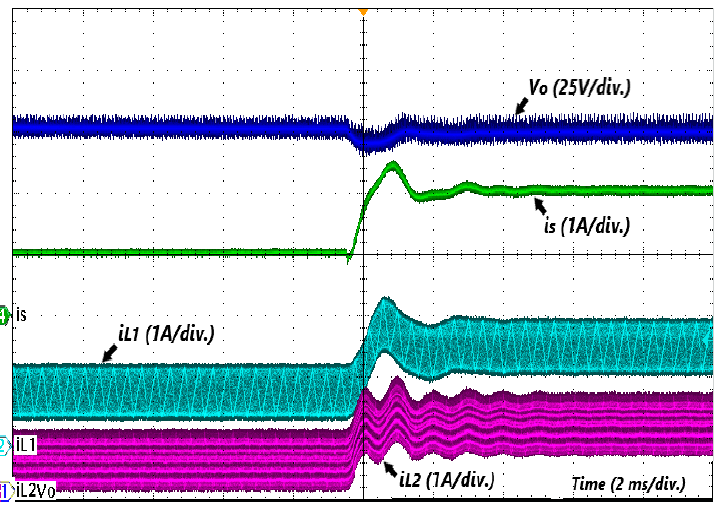
Figure 15. Transient response under load changes.